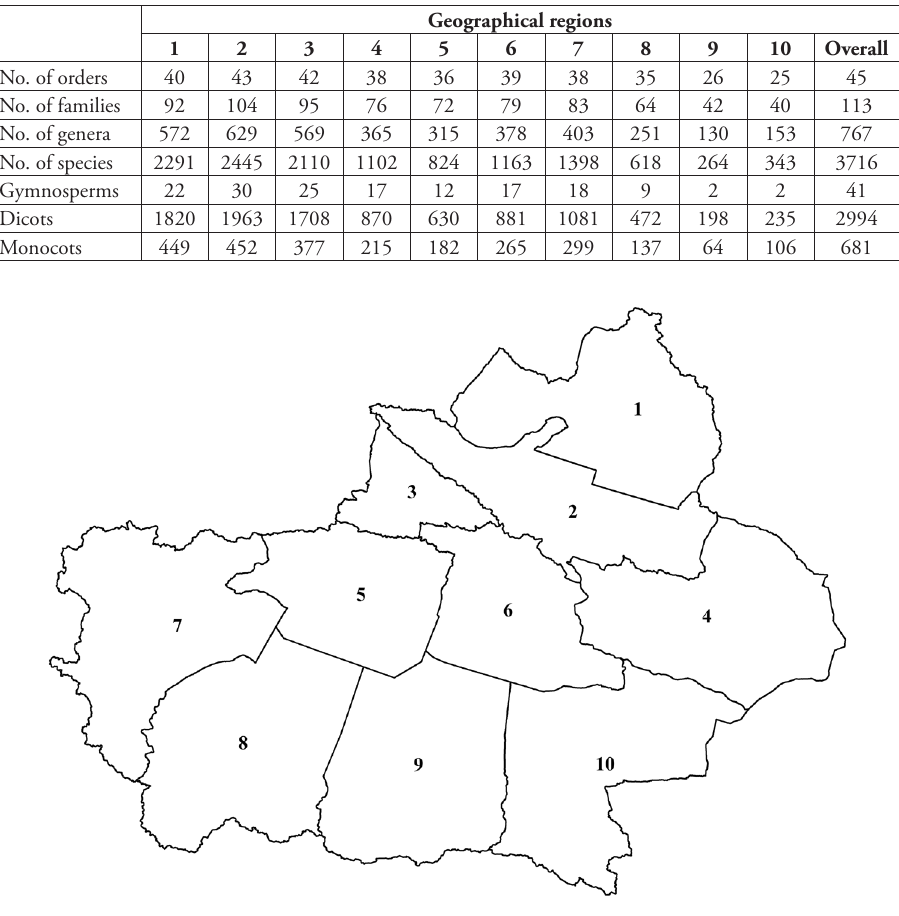
Figure 1. Map showing the 10 geographical regions of Xinjiang. Black number identifies geographi- cal regions: 1 North of Junggar Basin 2 South of Junggar Basin 3 Ily Valley 4 Eastern zone of Xinjiang 5 West-North Tarim Basin 6 East-North Tarim Basin 7 West Tarim Basin 8 West-Central Tarim Basin 9 South-Central Tarim Basin 10 East-Central Tarim